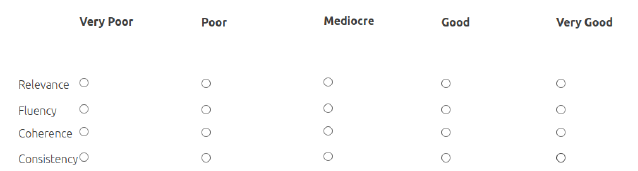
( a ) The main text and a set of abstractive summaries in our survey.